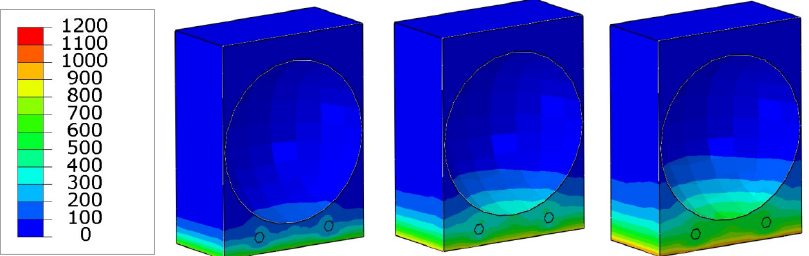
Figure 13. Temperature profile of the hollow sphere slab after 30, 60, and 90 min fire exposure with